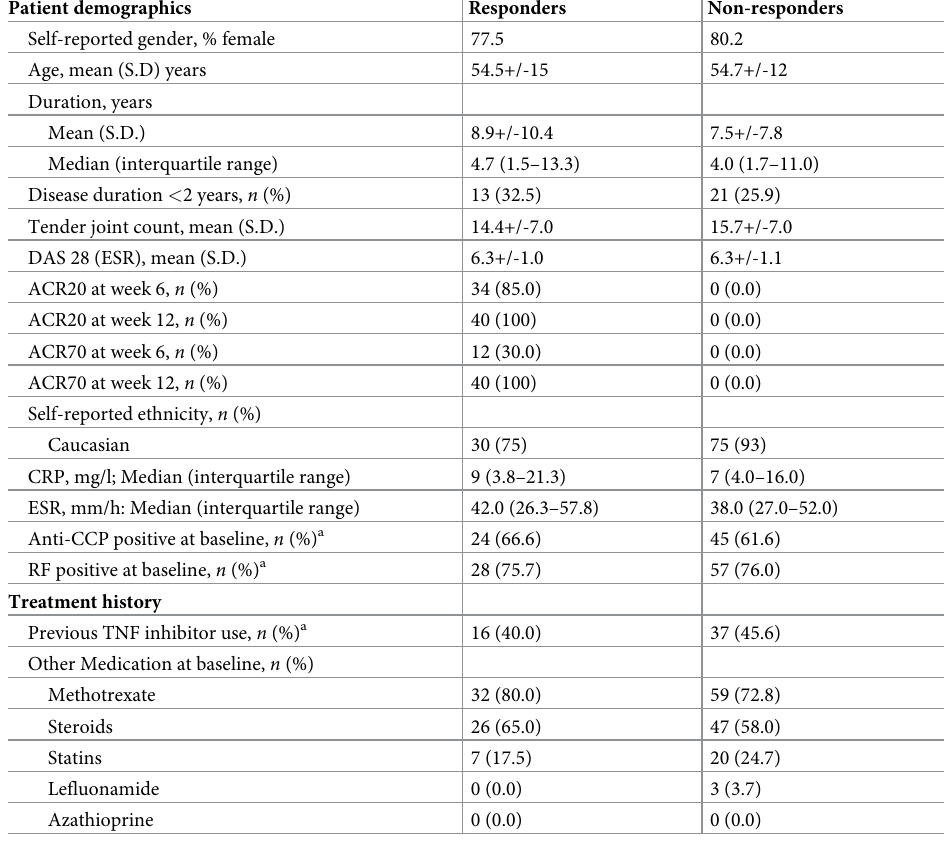
Table 3. Characteristics of study sample for whole exome